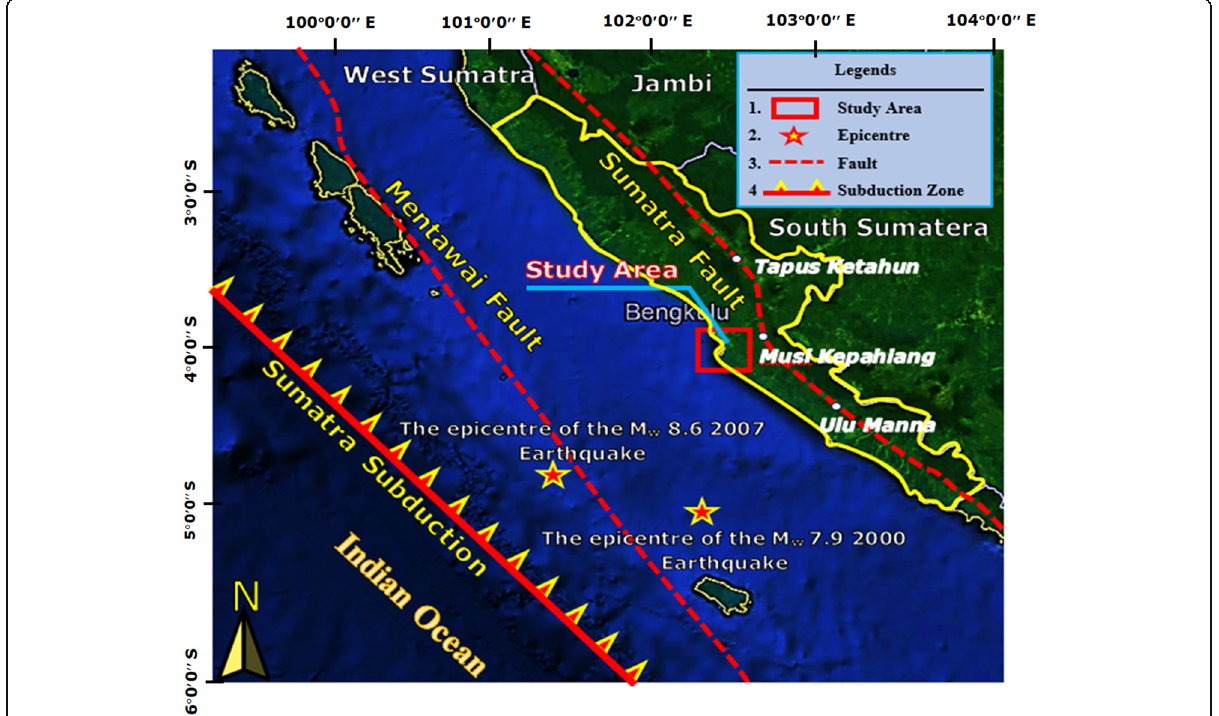
Fig. 1 Seismotectonic settings of Bengkulu Province, Indonesia and the epicentres of major earthquake on Bengkulu